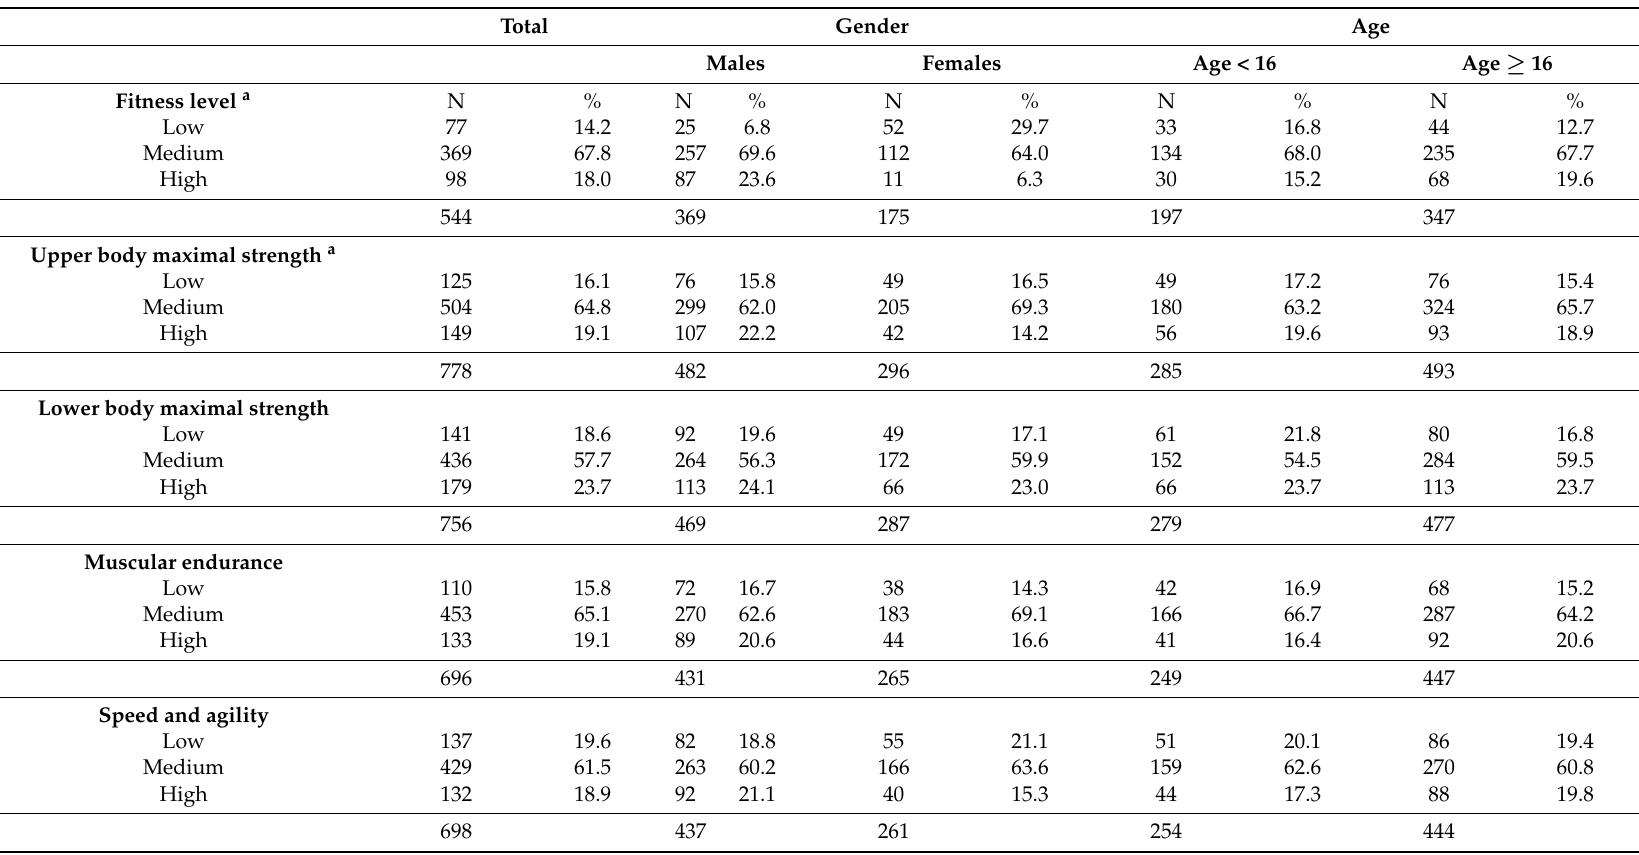
Table 2. Fitness levels and health-related fitness components in the total sample and by gender and